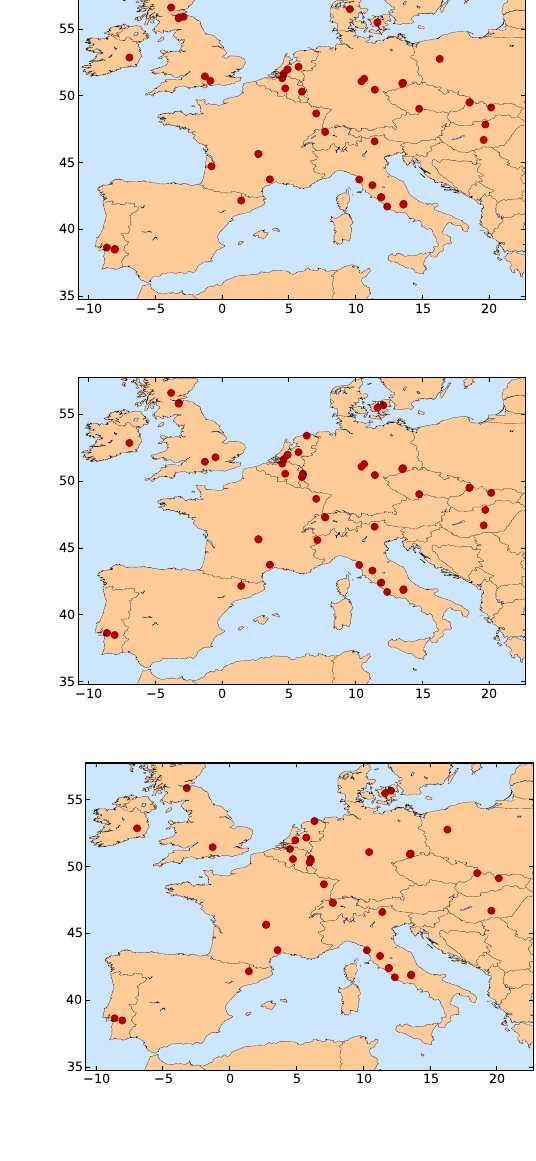
− 2 − 1 day ; negative values: sink) at the